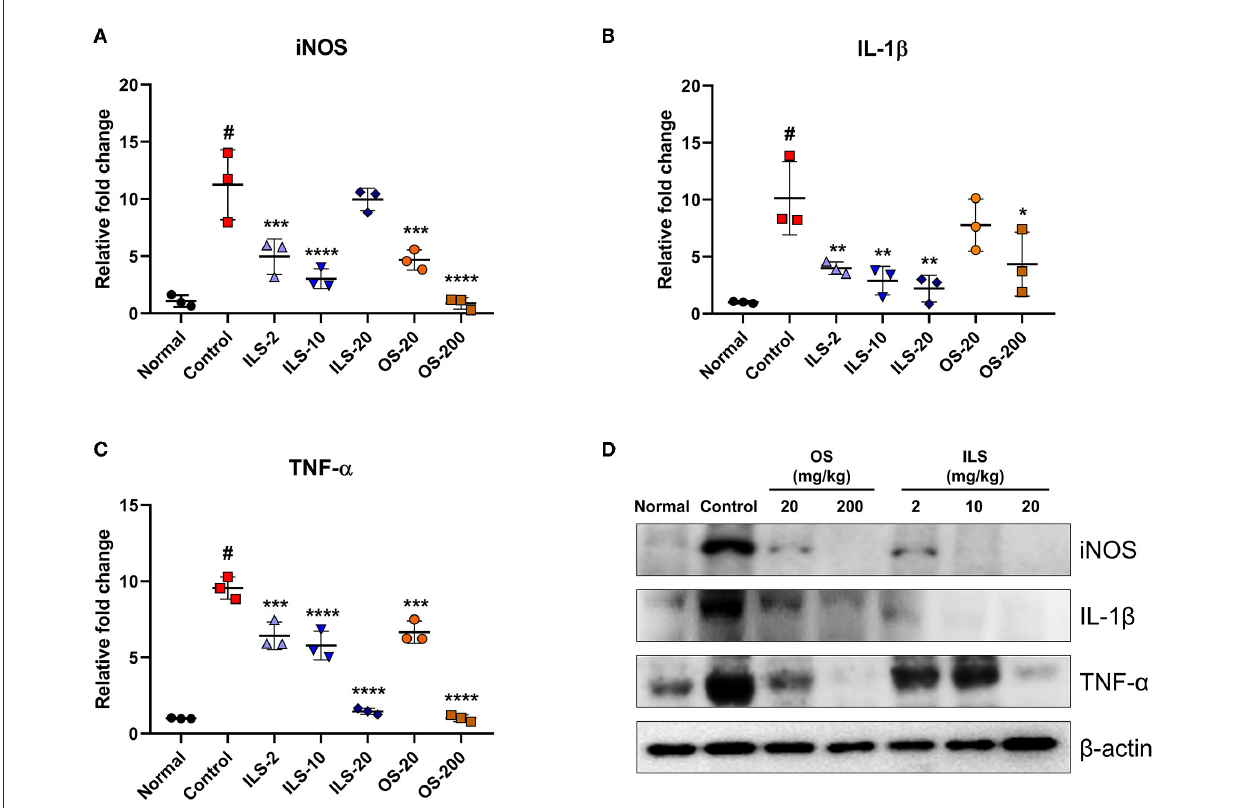
FIGURE3 Effect of Shinbaro 2 on the expression of iNOS, IL-1 β , TNF- α mRNA, and protein in LDH rats. (A–C) Gene expressions analyzed with tissue samples after Shinbaro 2 administration with two routes in LDH rats for 14 days: (A) iNOS , (B) IL-1 β , (C) TNF- α , and (D) western blot analysis of iNOS, IL-1 β , and TNF- α protein expression at 14 days. Data are expressed as mean ± SEM. Significant differences indicated as # A p < 0.001 compared vs. the blank group, *a p < 0.05, **a p < 0.01, ***a p < 0.001, and ****a p < 0.0001 vs. the control group were analyzed via one-way ANOVA with Tukey’s post-hoc